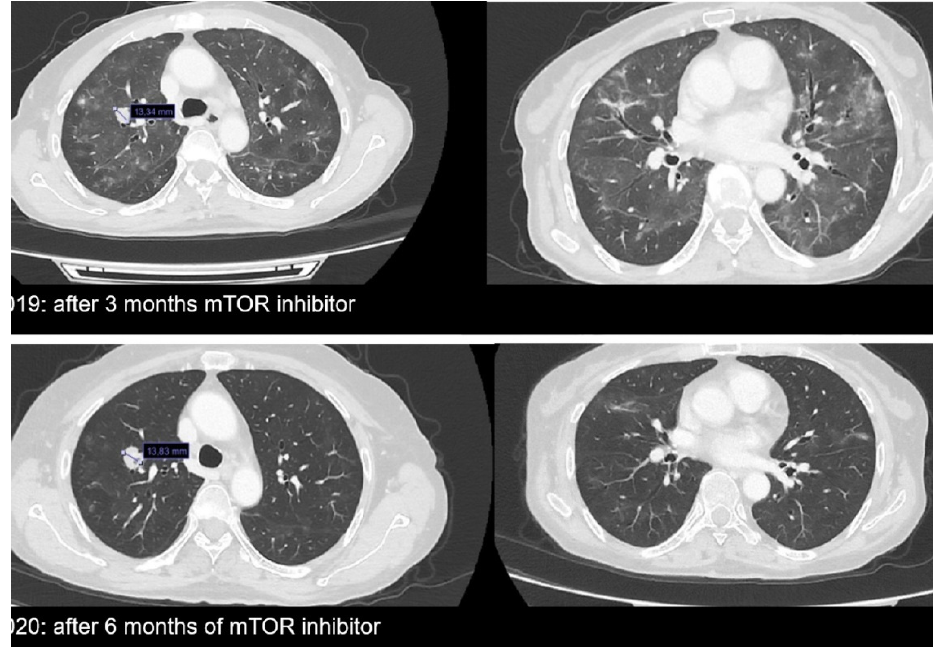
Figure 4. Computed tomography imaging in October 2019 and January 2020 during mTOR-inhibitor